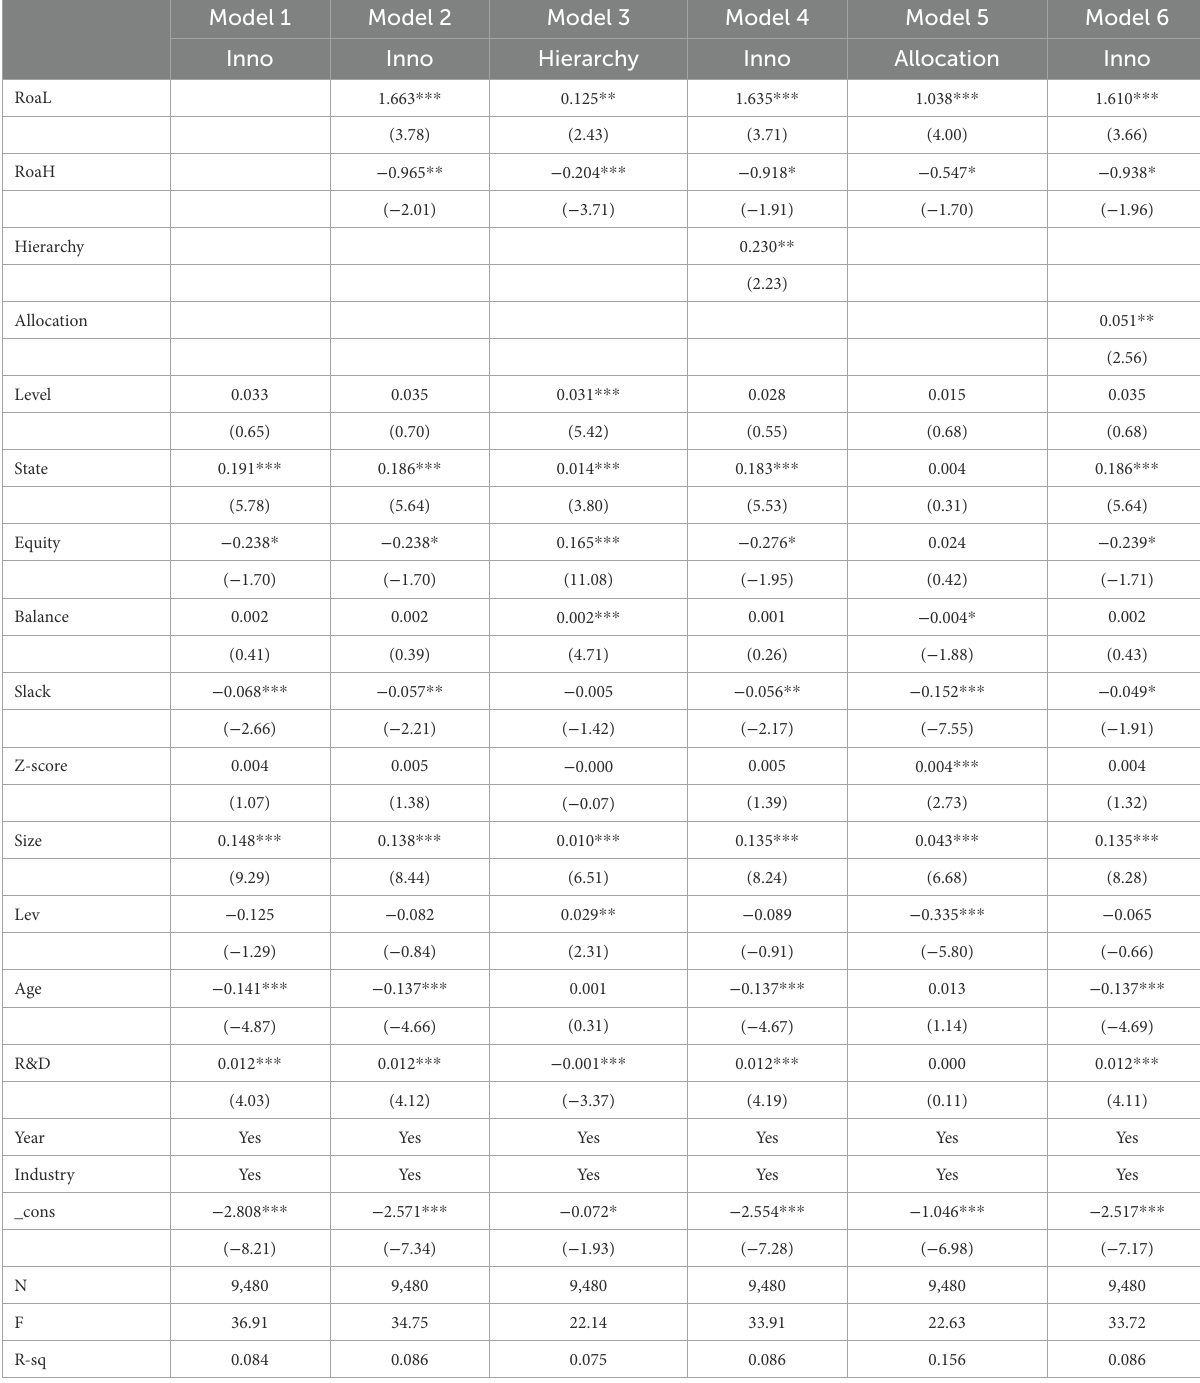
TABLE 2 Results of the mediating effect of the parent’